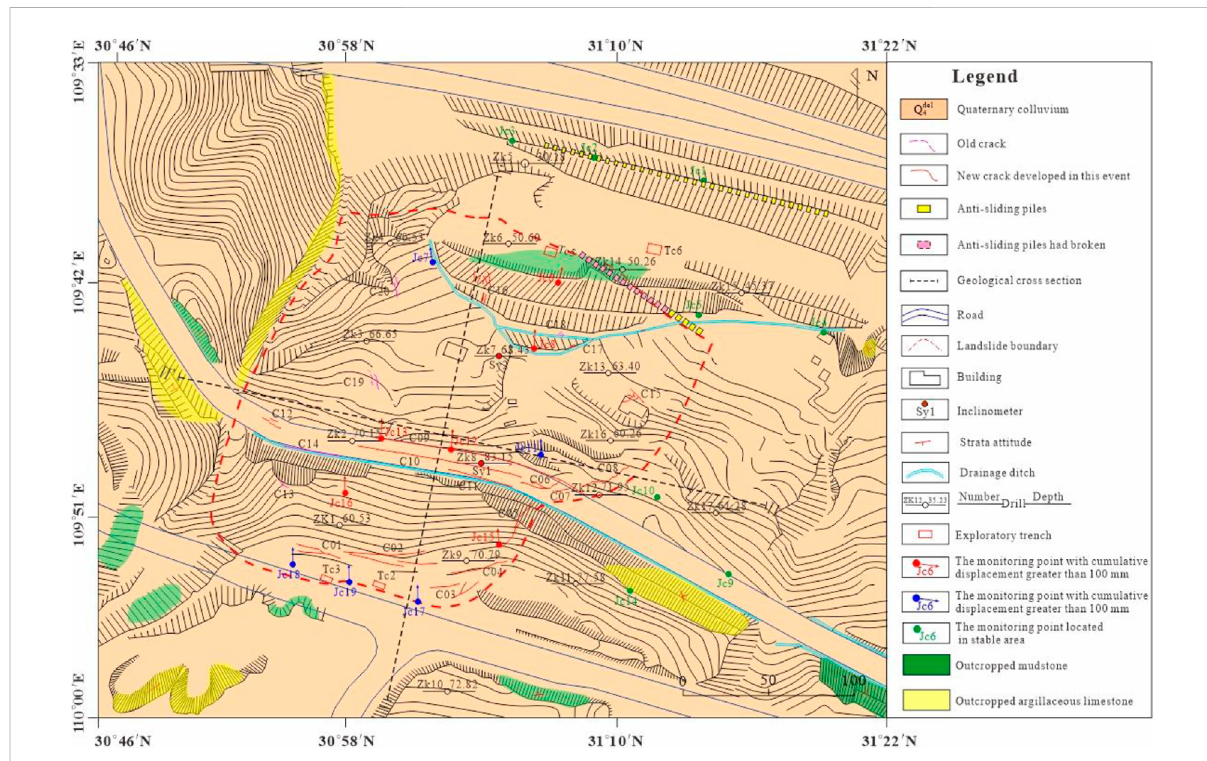
FIGURE 2 Layout map of the landslide area, showing the stratigraphic boundaries, landslide boundary and the location of boreholes, monitoring points, inclinometers, exploratory trenches and cracks. C13, C14, C18, C19, and C20 are old cracks induced by previous failure events, and the others are new cracks caused by this failure